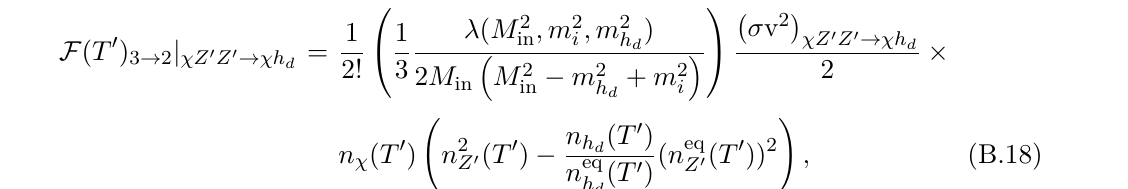
Z 0 Z 0 → χ Z 0 i i